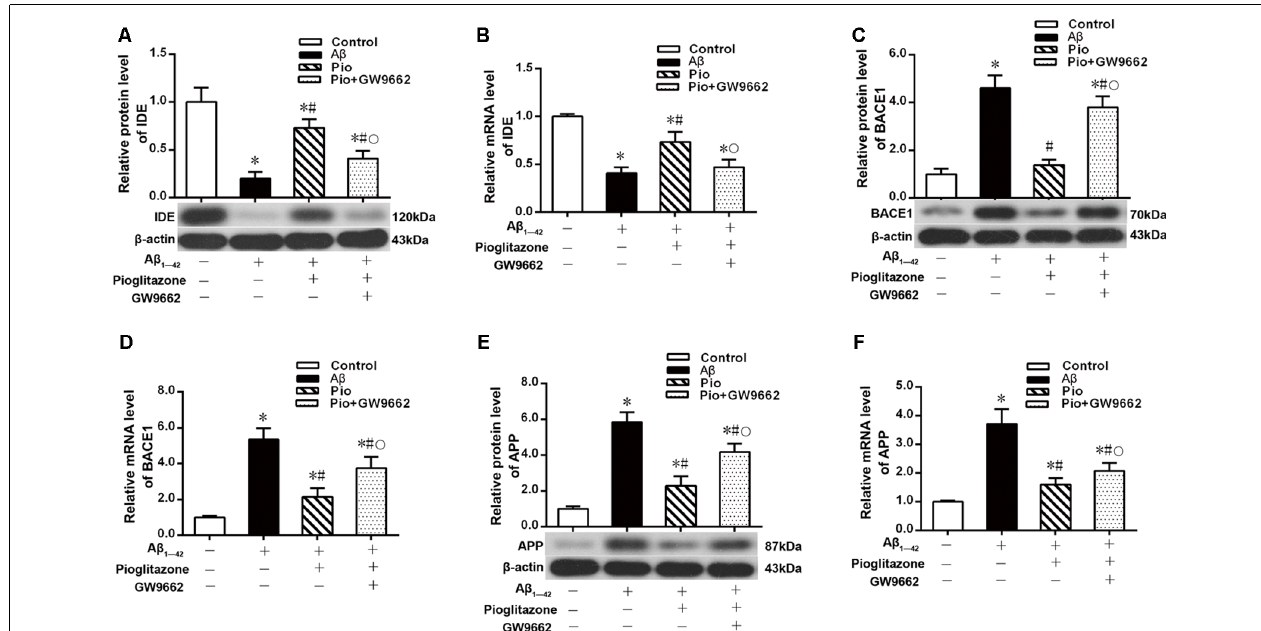
FIGURE 5 | Effects of pioglitazone on peroxisome proliferator-activated receptor γ (PPAR γ ) target gene expression in AD model neurons. (A) Western blot results for insulin-degrading enzyme (IDE). (B) Real-time PCR results for IDE. (C) Western blot results for β -amyloid cleavage enzyme 1 (BACE1). (D) Real-time PCR results for BACE1. (E) Western blot results for amyloid precursor protein (APP). (F) Real-time PCR results for APP. n = 6 wells per group. ∗ P < 0.05 compared to the control group, # P < 0.05 compared to the A β group, ◦ P < 0.05 compared to the Pio group.